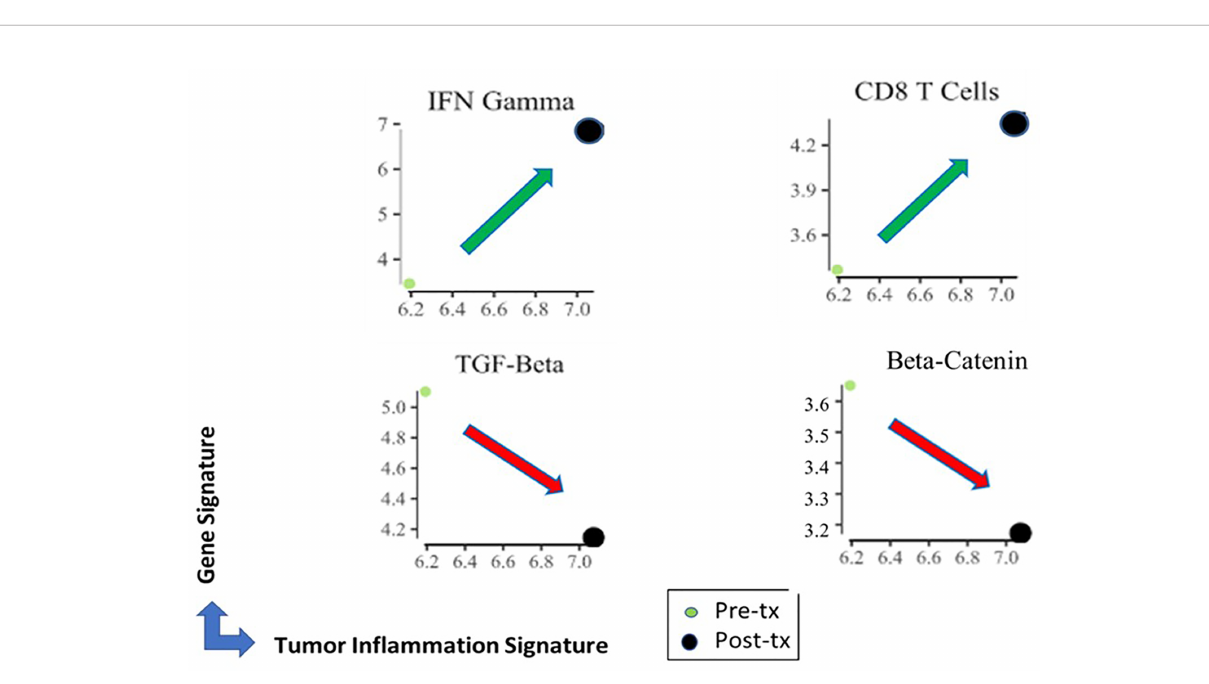
FIGURE 3 | Key changes in pre and post treatment RNA gene expression transcriptome analyses by nanostring IO 360 panel. Ad-p53 treatment increased the Tumor In fl ammation Signature and interferon signaling, decreased TGF-beta and beta-catenin signaling resulting in an increased CD8+ T cell signature which is associated with increased clinical responses to immune checkpoint inhibitor